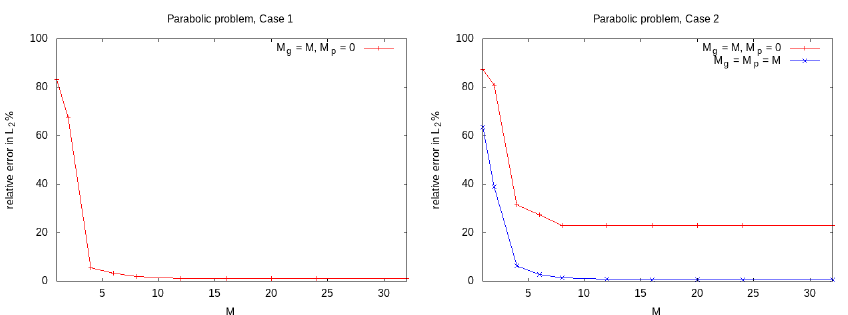
Figure A3. Parabolic problem with α = 100 at the final time. Case 1 ( left ) and Case 2 ( right ): Relative L 2 error with a different number of multiscale basis